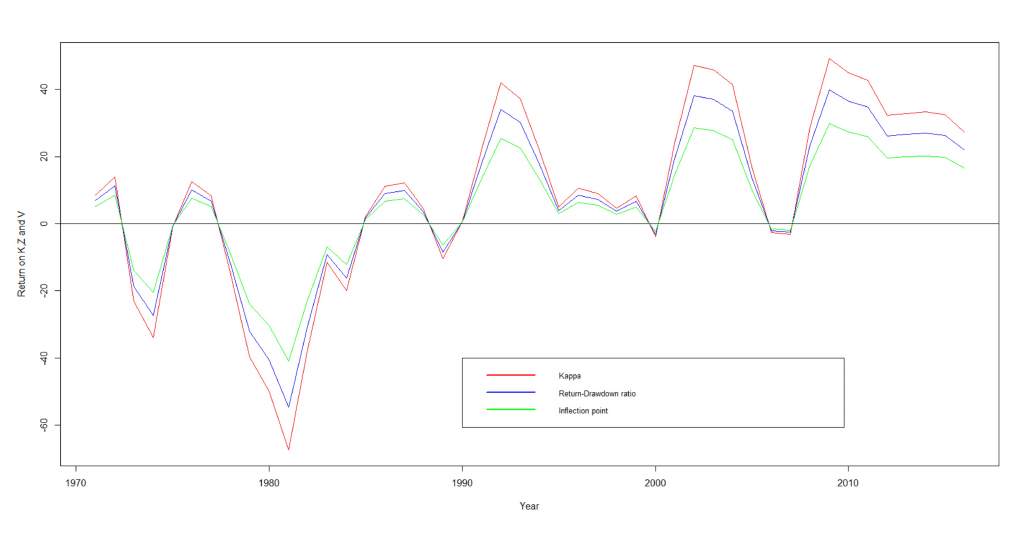
Figure 5. Returns from κ -red, ζ -blue, and ν -green vs. year in x-axis for fixed